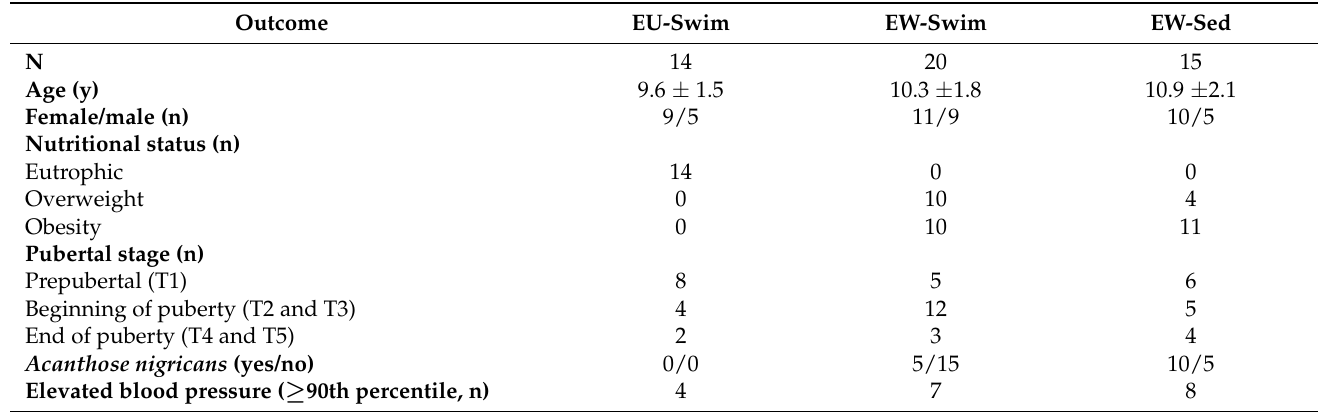
Table 1. Sample characteristics at baseline in ‘eutrophic swimming’ (EU-Swim), ‘excess weight swimming’ (EW-Swim), and ‘excess weight sedentary’ (EW-Sed).